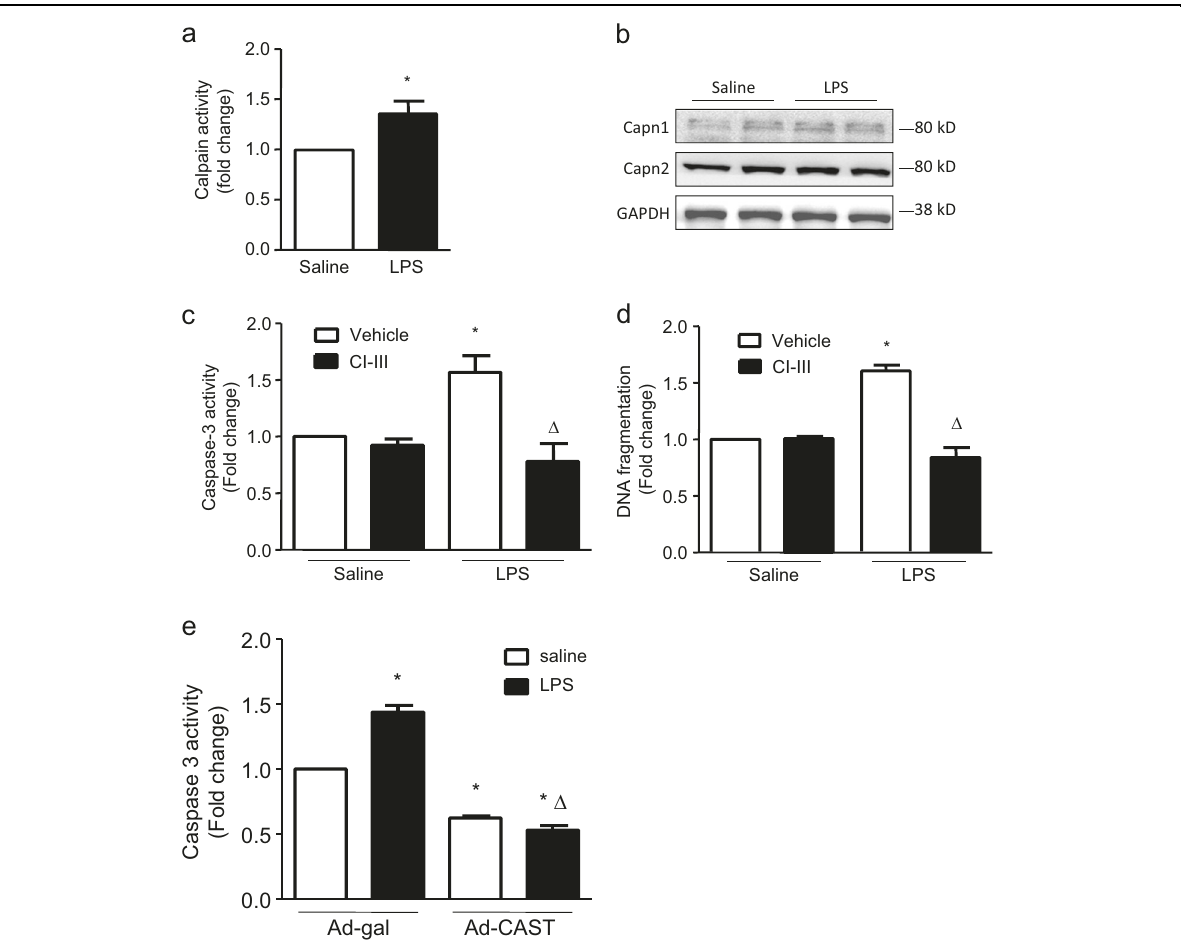
Fig. 2 Role of calpain in LPS-induced PMEC apoptosis. PMECs were treated with calpain inhibitor III (CI-III, 5 µmol/l) for 1 h and then stimulated with LPS (1 µg/ml) for 18 h. Calpain activity ( a ) and the expression levels of calpain1 and calpain2 ( b ) were measured. Caspase-3 activity ( c ) and DNA fragmentation ( d ) were examined. Calpastatin overexpression adenoviruses (Ad-CAST) and Ad-gal were used as the control to infect PMECs before LPS stimulation, and caspase-3 activity ( e ) was examined. The data are presented as the means ± SD of 3 independent experiments. * P < 0.05 vs. the Sham vehicle/saline group. Δ P < 0.05 vs. the LPS vehicle/saline